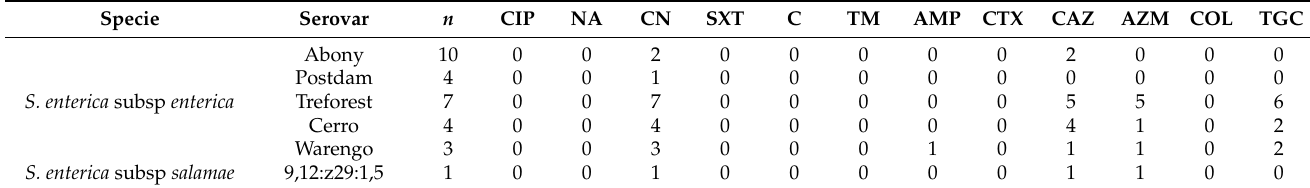
Table 3. Antimicrobial resistance pattern of Salmonella strains.